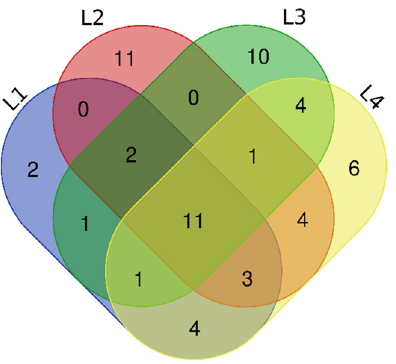
Figure 1: Venn diagrams for comparison of volatile components in four functional liquors.